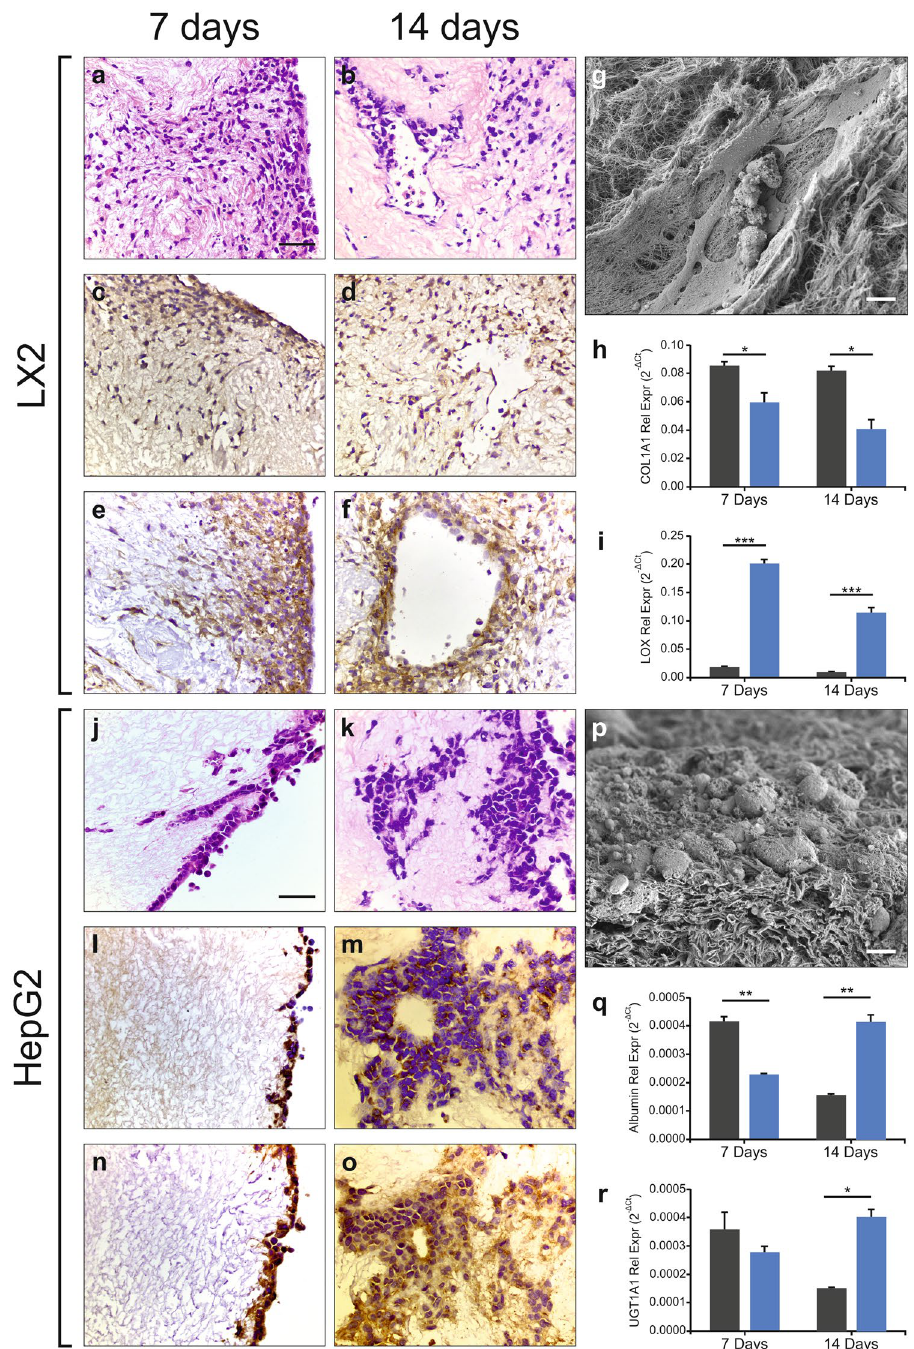
Figure 4. Biocompatibility of ALTCs with various cell lines. Reseeded HepG2 cells were positive for ( a,d) , H&E, ( b,e) , AFP and ( c,f) , EPCAM staining at both 7 (left panel) and 14 days (right panel). At 7 days the cells appear to have only attached to the outer surface of the ALTCs, however, at 14 days, they were able to migrate and occupy the ALTC’s parenchymal space. ( g ) SEM analysis confirming cellular attachment of the HepG2s cells to the ALTCs at 14 days.Quantitative comparison of ( h) , albumin and ( i ), UGT1A1 mRNA expressions of HepG2 grown on 2D plastic (black bar) and those reseeded on ALTCs (blue bar), show contrasting patterns after 7 and 14 days. Similarly, reseeded LX2 cells stained positive for ( j,n ), H&E, ( k,o ), PDGFB- β and ( l,p ), TFG- β at both 7 and 14 days. In contrast to HepG2, LX2 cells were able to migrate and occupy the ALTCs sinusoidal space at 7 days and were more abundant after 14 days. ( p ), SEM analysis confirming cellular attachment of the LX2 cells to the ALTCs at 14 days. Quantitative comparison of ( q ), COL1A1 and ( r) , LOX mRNA expressions of LX2 cells grown on 2D plastic (black bar) and those reseeded n ALTCs blue bar), confirming significantly different patterns. Data are expressed as mean ± s.e.m * p < 0.05, ** p < 0.005, *** p < 0.0001. Scale bars, 50 μ m ( a–f , j–o) , or 10 μ m ( g,p ). Biological replicates (n > 4) are performed for all